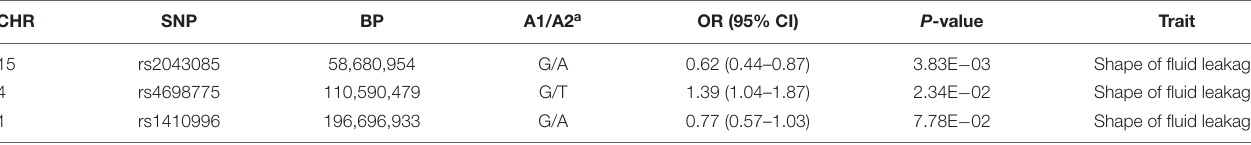
TABLE 3 | Stratified association analysis of three SNPs with shape of fluid leakage on